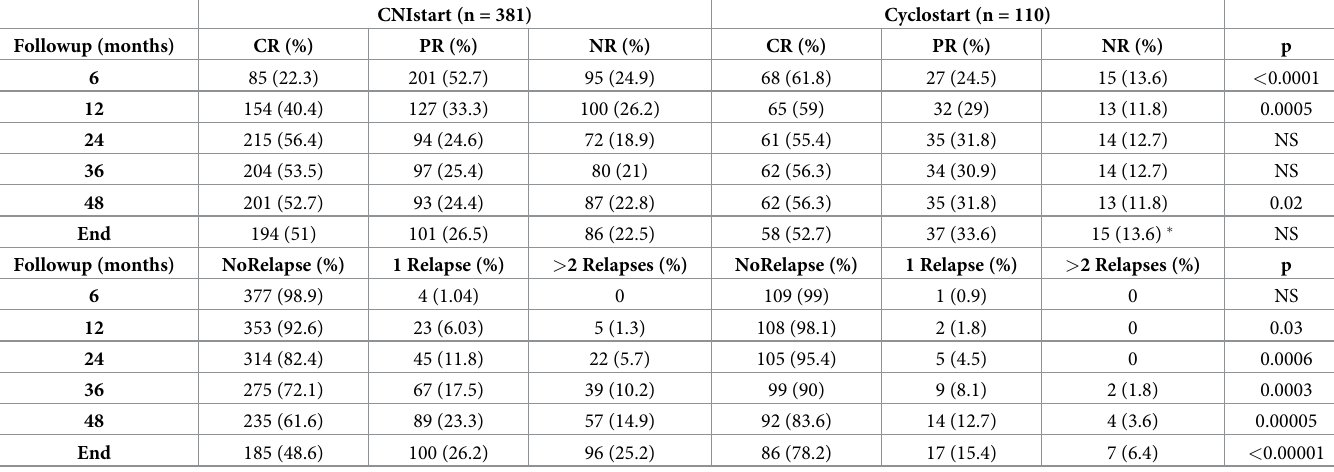
Table 4. Response of renal function and rate of relapses according to initial treatment with CNIs (n = 381) or Cyclo (n = 110), at different time